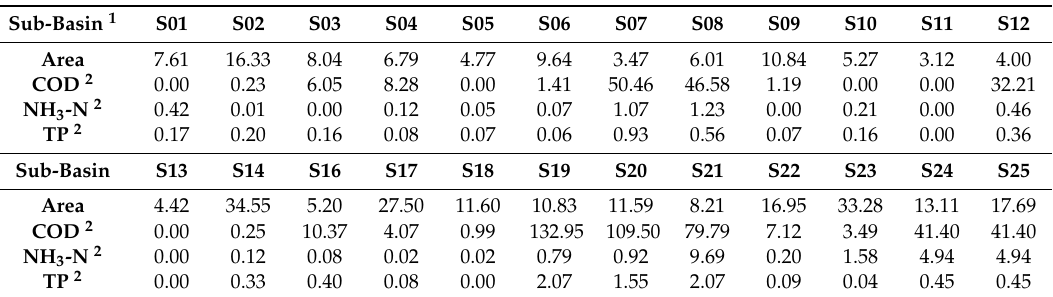
Table 2. Estimated WEC for the three contaminants in the sub-basins of the Xian-Jiang watershed during the dry season.